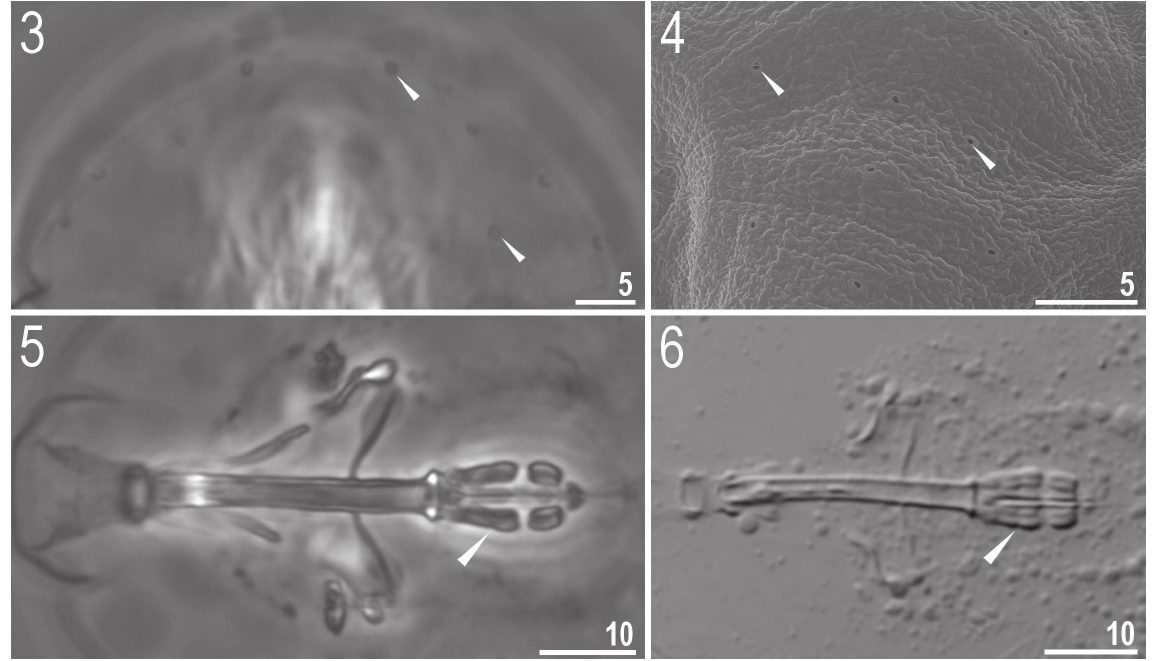
Figs 3–6. Macrobiotus polypiformis sp. nov. 3 . Cuticular pores visible in PCM (paratype). 4 . Cuticular pores visible in SEM (paratype). 5–6 . Bucco-pharyngeal apparatus (dorso–ventral projection), the filled arrowhead indicates the first macroplacoid with central constriction (Fig. 5 = paratype in PCM; Fig. 6 = holotype in DIC). Scale bars in